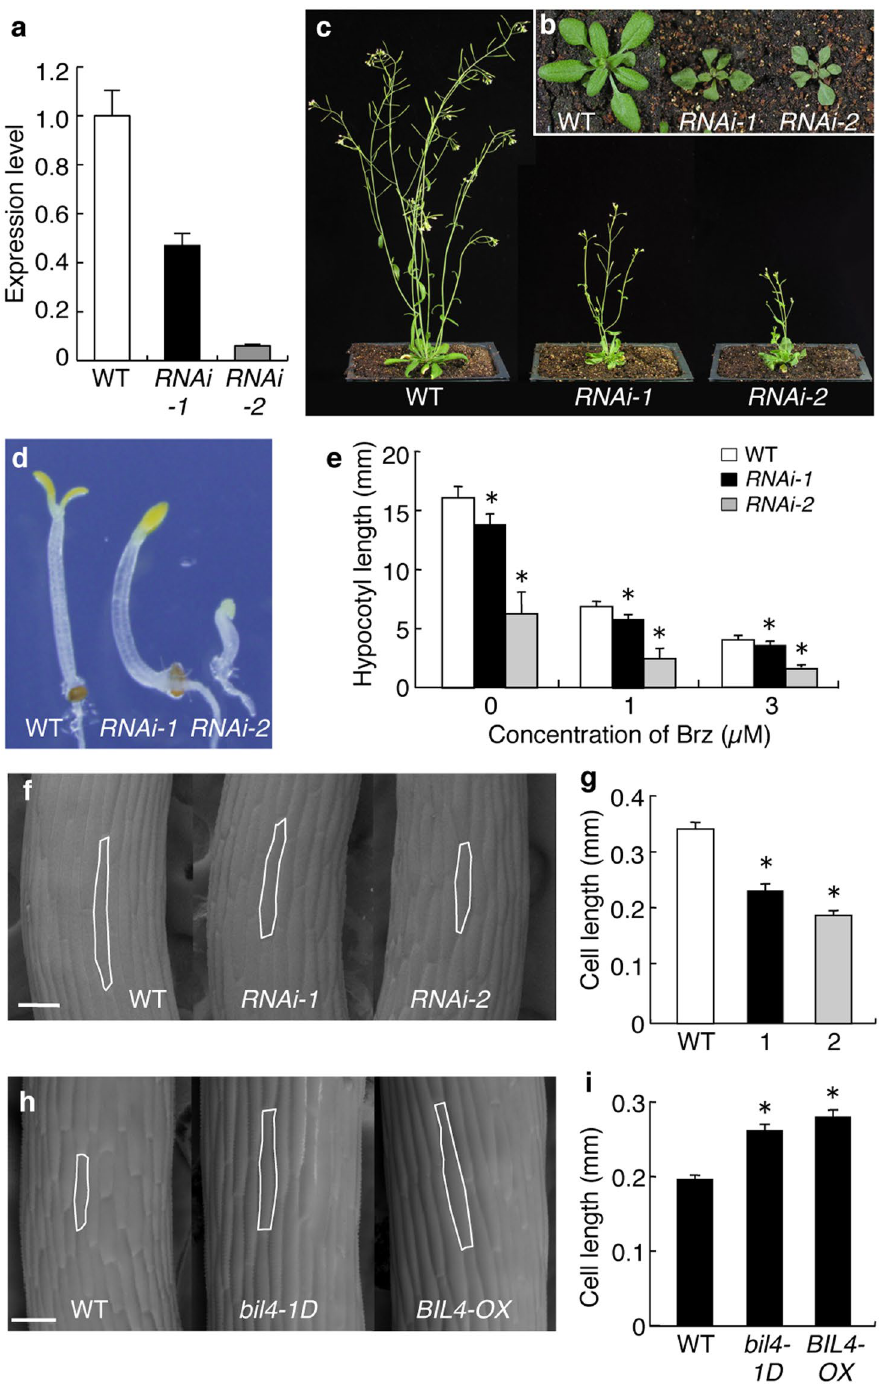
Figure 2. BIL4 is important for cell elongation. ( a ) qRT-PCR analysis of BIL4 expression in wild-type (WT), BIL4-RNAi-1 ( RNAi-1 ) and BIL4-RNAi-2 ( RNAi-2 ) seedlings grown in the dark for 3 days. The results are presented as the mean ± s.d. ( b , c ) Three-week-old ( b ) and 5-week-old ( c ) wild-type and BIL4-RNAi plants. ( d , e ) Phenotype ( d ) and hypocotyl length ( e ) of wild-type and BIL4-RNAi seedlings grown on medium containing 3 µ M Brz in the dark for 6 days. The results are presented as the mean ± s.d., n > 30 seedlings. Asterisks indicate a significant difference from the wild-type plant ( P < 0.01 by Student’s t -test). ( f to i ) SEM images ( f,h ) and length ( g,i ) of the hypocotyl cells. The typical cell phenotype is marked by a white frame. Scale bar, 100 µ m. The results are presented as the mean ± s.e.m. Asterisks indicate a significant difference relative to wild-type plants ( P < 0.01 by Student’s t -test). RNAi seedlings were germinated on 1 µ M Brz (n > 17 cells; f,g ), and overexpressing seedlings were germinated on 3 µ M Brz (n > 35 cells; h and i ) in the dark for 7